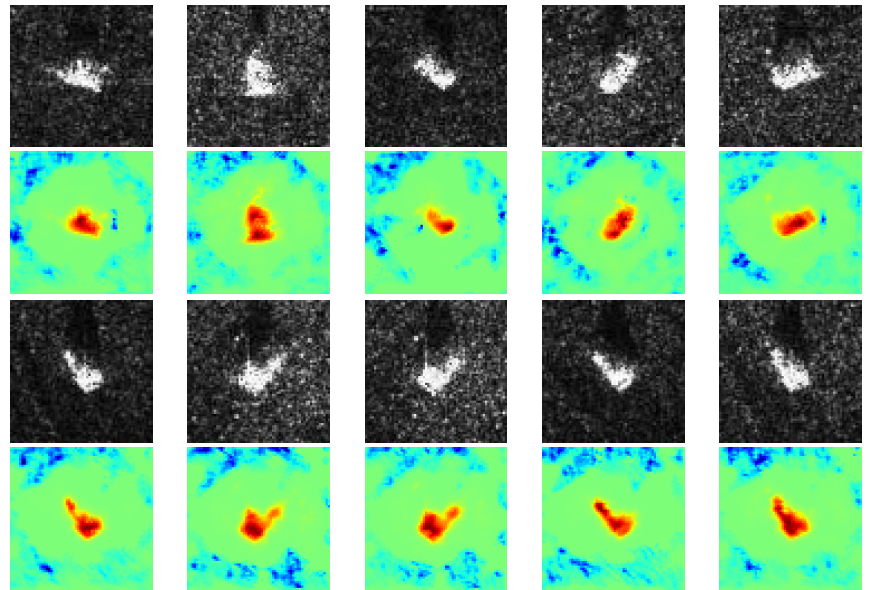
Figure 8. Positive contributions are targets while negative contributions are scattered speckles. The first and third rows are SAR images of two classes: D7 and ZSU_23_4. The second and fourth rows are the corresponding heatmaps generated by our